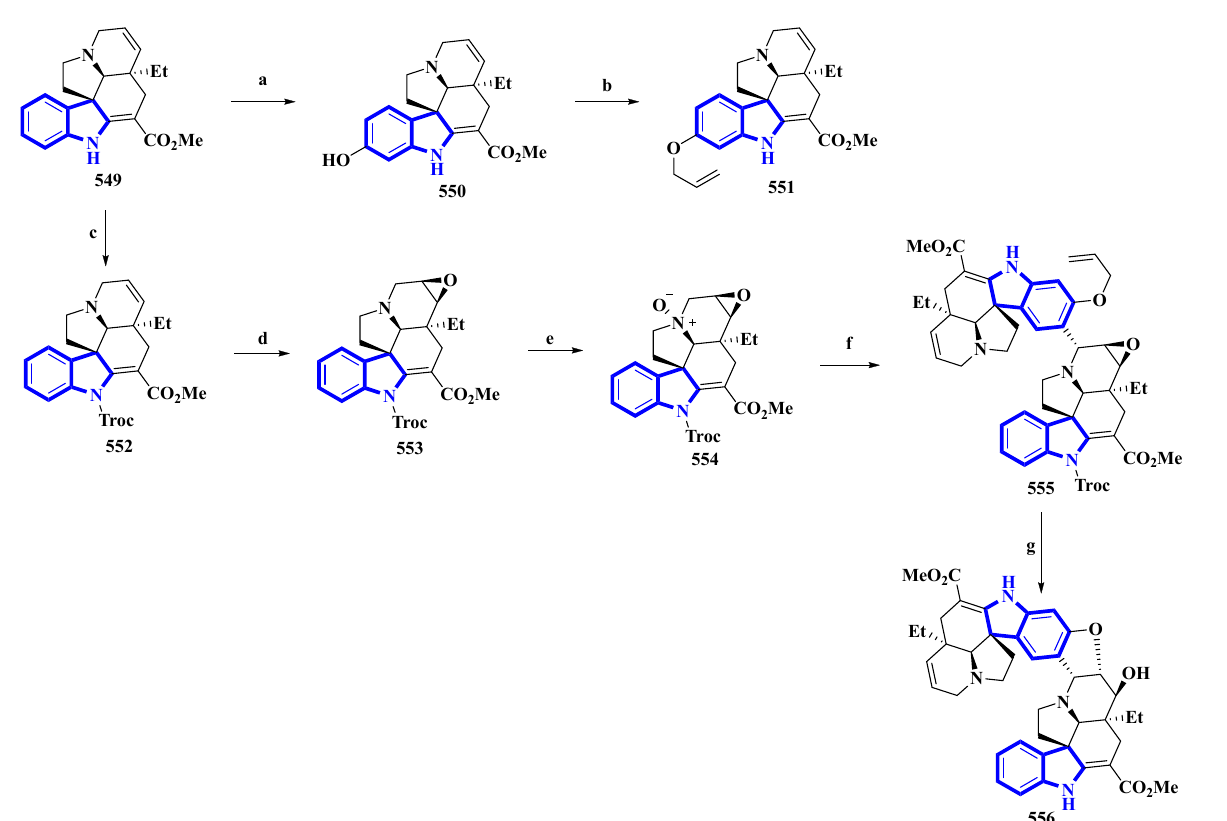
Figure 26. The semi-synthesis of ( − )-melodinine K 556 . (a) T16H yeast, 64%; (b) Allyl bromide, K 2 CO 3 , DMF, 68%; (c) NaH, TrocCl, THF/DMF 0 °C, 92%; (d) TFA then m -CPBA, DCM, − 10 °C then rt, 38%; (e) m -CPBA, DCM, 0 °C, 36%; (f) (1) TFAA, DCM, 0 °C to rt and (2) 551 , DCM, 78%; (g) (1) Pd(PPh 3 ) 4 , pyrrolidine, DCM, rt and (2) Zn, KH 2 PO 4 , THF, 60 °C, 40%.